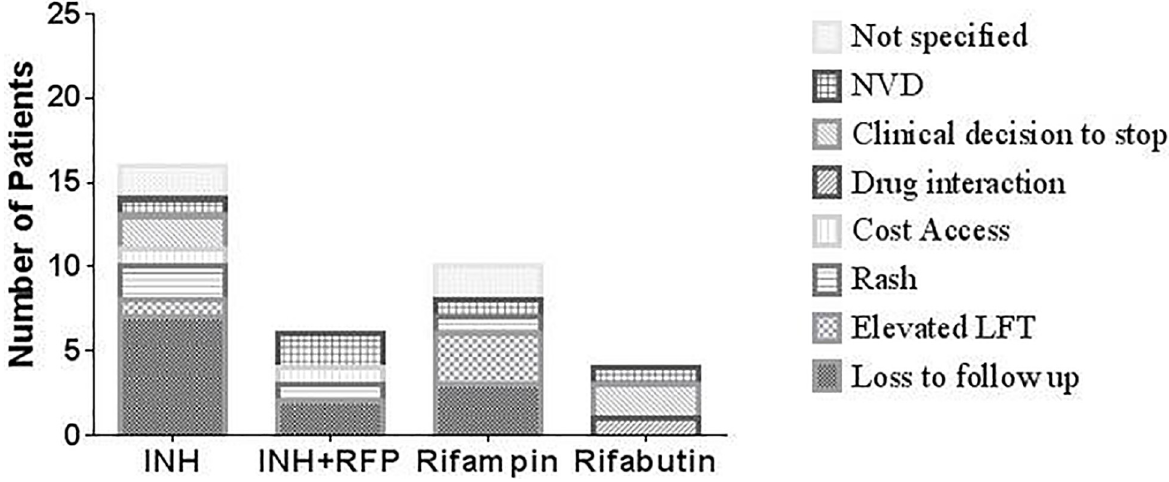
Fig 3. Showing the number of patients discontinuing therapy and the primary documented causes by drug